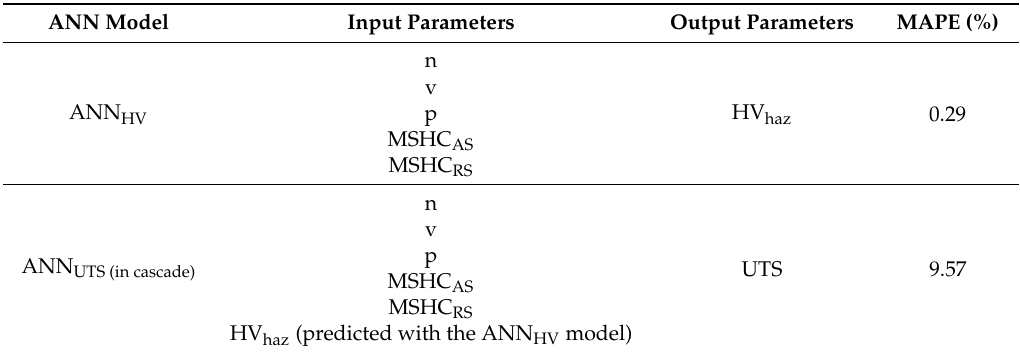
Table 5. Mean absolute percentage error computed for hardness and ultimate tensile strength of AA AA5754 H111 plates welded with the friction stir welding process.